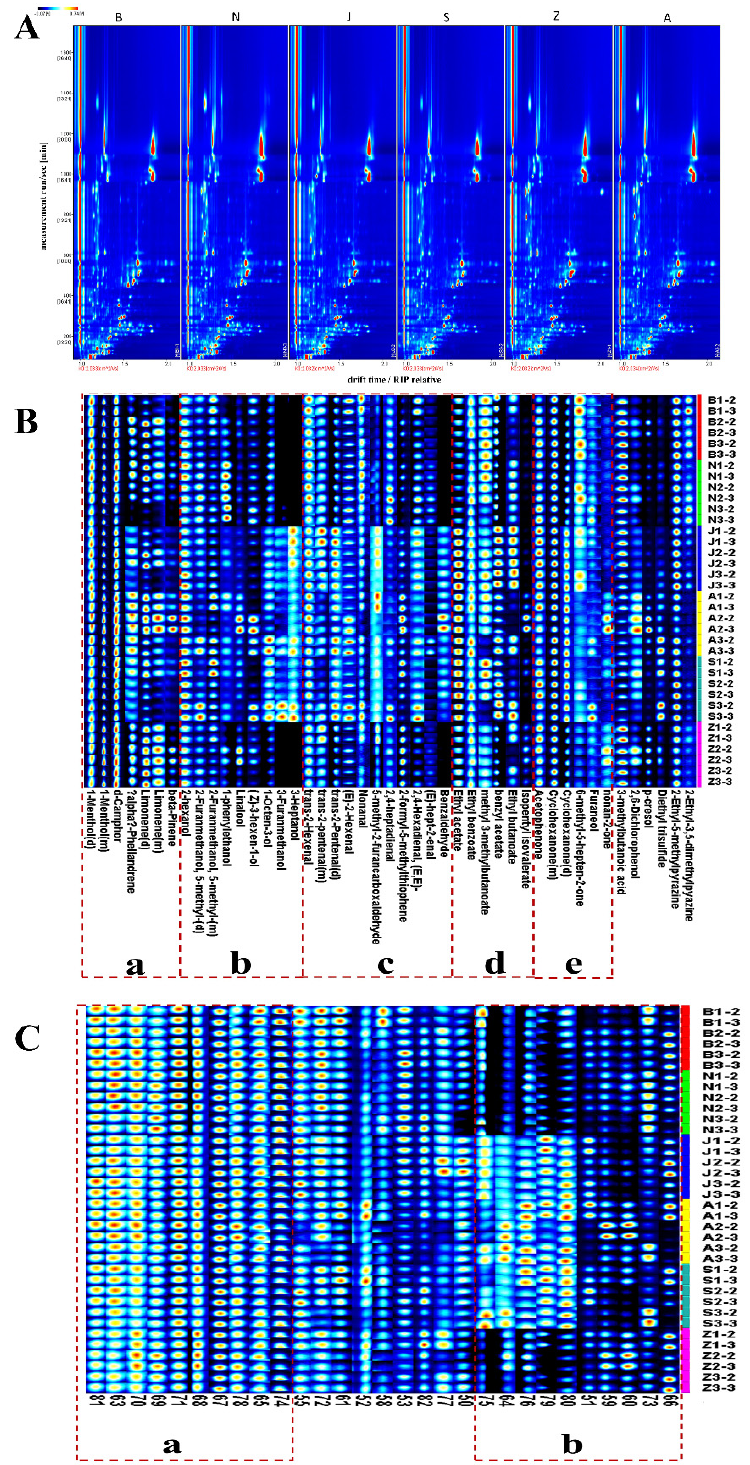
Figure 1. ( A ) Two-dimensional chromatogram results of VOCs in SS of different regions; ( B ) the VOCs fingerprint of different regions of SS; ( C ) the fingerprints of unknown compounds in SS from different regions.